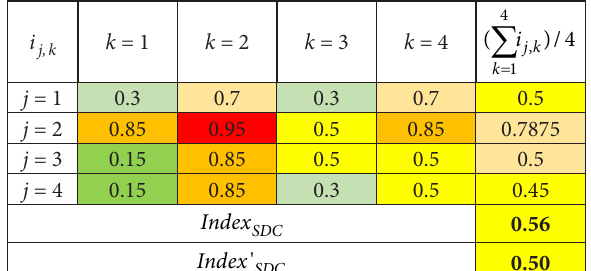
Table 7. The assessment of susceptibility to destruction in combat for